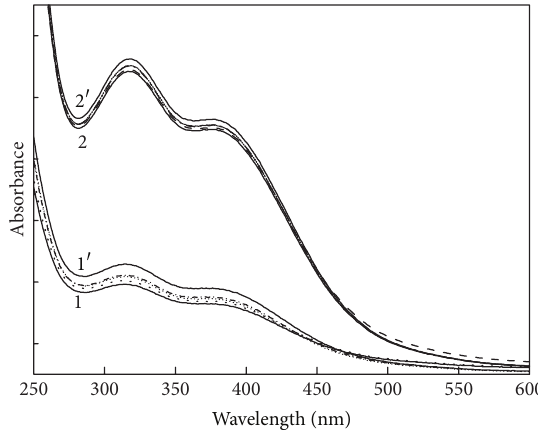
Figure 7: Optical absorption spectra of DABA-Co(II) in aqueous solution and at room temperature. Spectrum 1 was obtained with DABA-Co(II) solution saturated with N 2 . Spectrum 2 was obtained withDABA-Co(II)solutionsaturatedwithO 2 .Spectra1 󸀠 and2 󸀠 were obtained on the fifth cycle of alternate bubbling of N 2 and O 2 into the DABA-Co(II) solution ( 𝐶 DABA = 4.0 × 10 −4 mol ⋅ dm −3 and 𝐶 Co ( II ) = 2.0 × 10 −4 mol ⋅ dm −3 ).